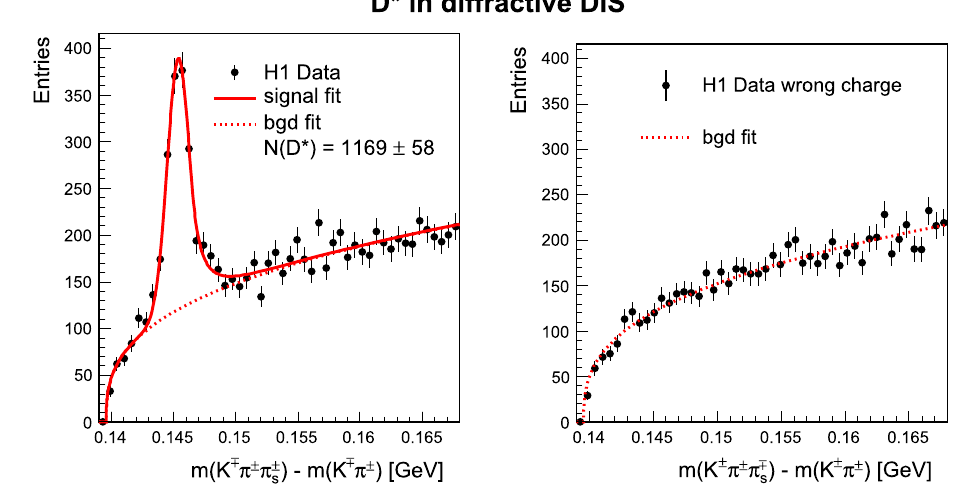
Fig. 2 The (cid:10) m distributions in the data for the right charge sample with the combined signal and background fit indicated by the solid and dotted line , respectively, is shown in the left figure . The wrong charge